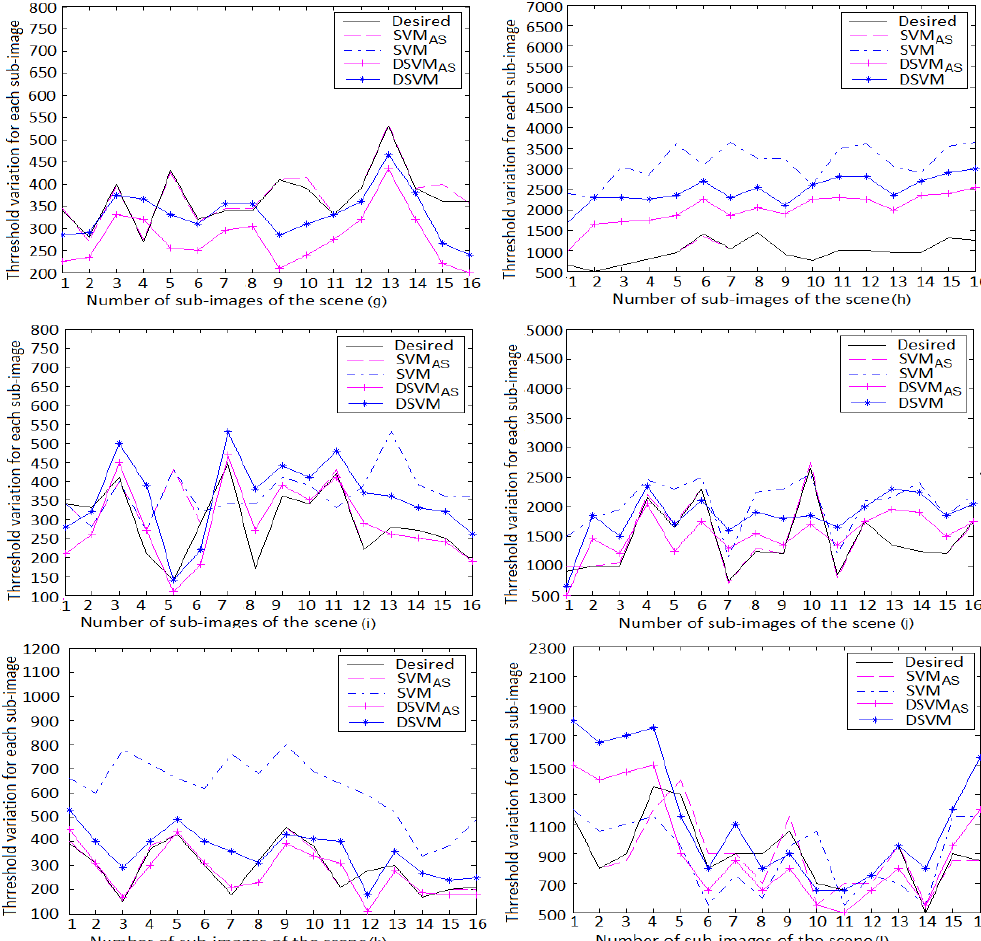
Figure 12. Variation of the thresholds for the sub-images of the 800 × 800 resolution scenes. We found that SVM AS gives similar results to those of the human visual system (HVS) on the scenes ( g – l ). It is shown that the DSVM AS model achieves a better precision than SVM and DSVM on the scenes ( h – l ). The mean square error ranges for the learning models are listed in Table 7. We find that SVM